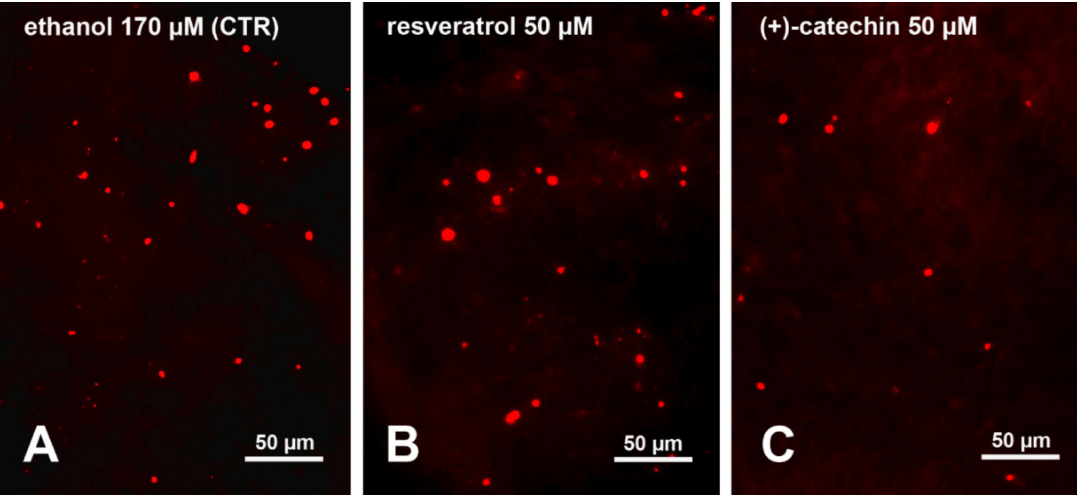
Figure 1. Limitation of naturally occurring neuronal death (NOND) in the postnatal cerebellum after ex vivo treatment with polyphenols (PPs). The nuclei of dead cells are strongly fluorescent in red after incubation with propidium iodide (PI). PI is a fluorescent intercalating DNA stain that is not membrane permeable. Thus, it only enters the nucleus of damaged cells and can therefore be used to di ff erentiate dead cells (apoptotic, necrotic, etc.) from healthy cells based on membrane integrity. As 170 mM ethanol in which PPs are dissolved does not significantly alter cell death, it can be used as a baseline control (CTR) for the experiments to ascertain the e ff ects of PPs onto NOND. The three panels are representative images of the experiments carried out with ethanol 170 mM ( A ) and with individual PPs, resveratrol 50 µ M ( B ) and ( + )-catechin 50 µ M ( C ).